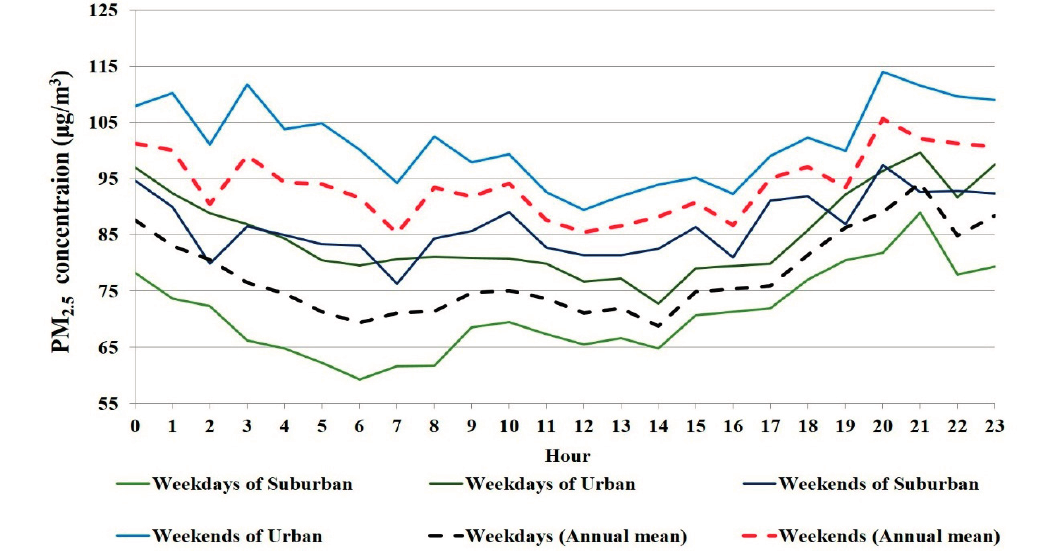
Figure 4. Day-of-week pattern in urban and suburban areas. Though urban concentration